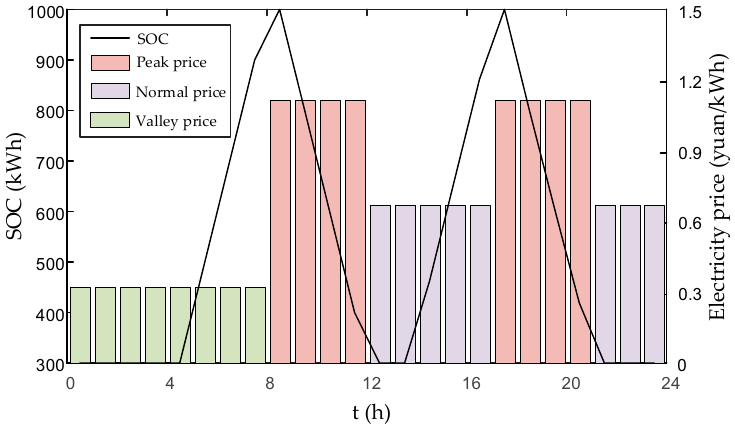
Figure 3. ESS-state of charge (SOC) result in the base case.